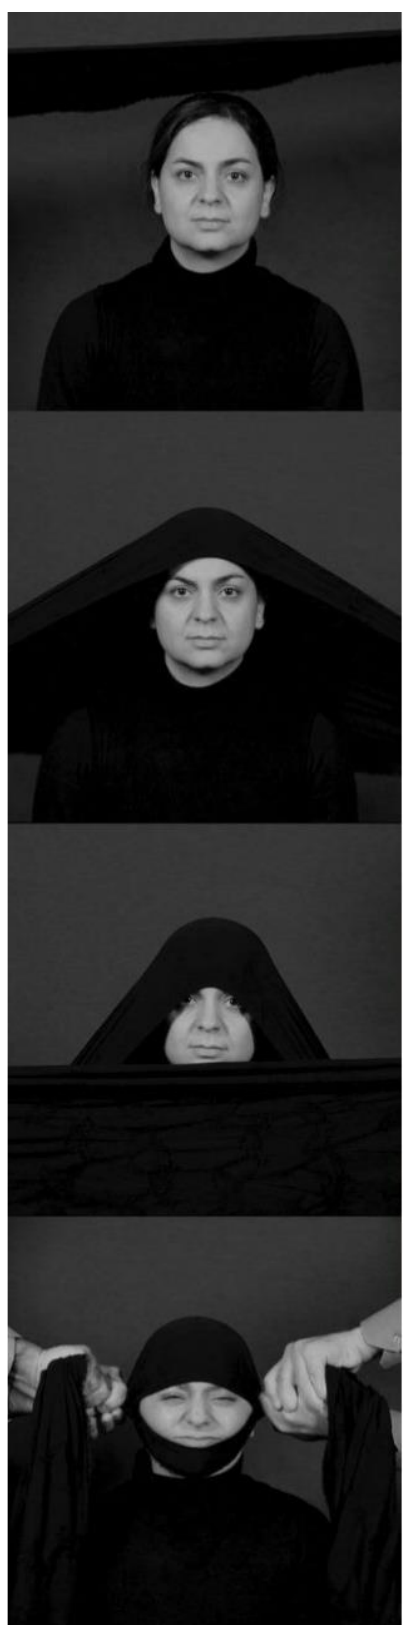
Sepideh Tajalizadeh Dashti, My Family Men, 2018. Film